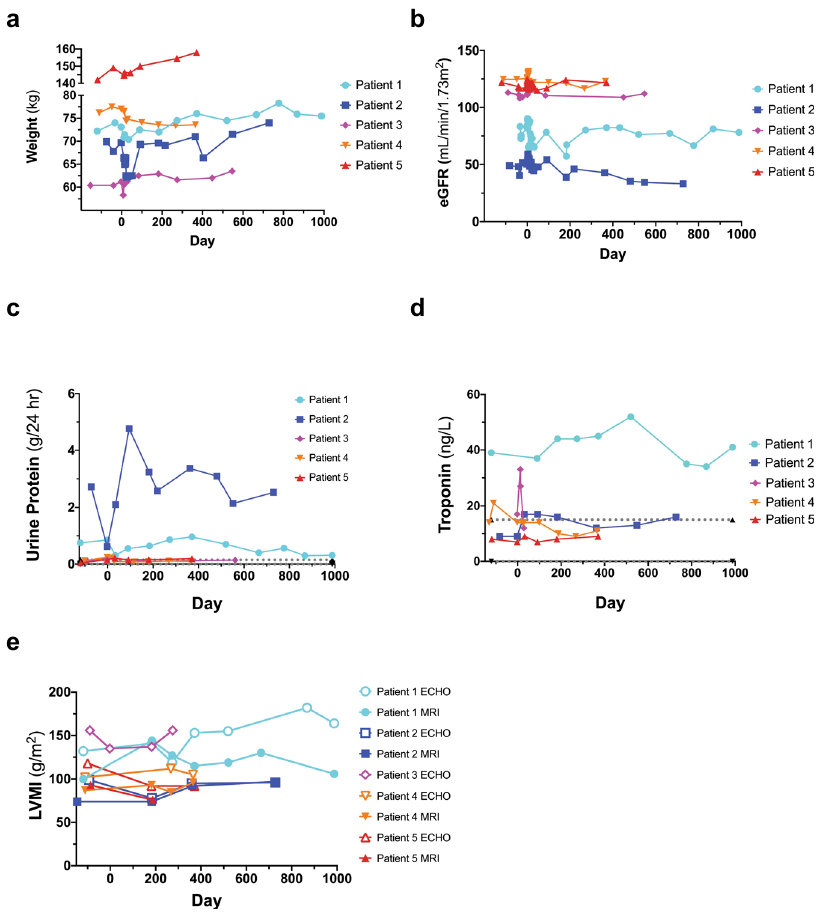
Fig. 4 Clinical parameters. Weight ( a ), estimated Glomerular Filtration Rate (eGFR) ( b ), urinary protein secretion ( c ), troponin ( d ), and Left Ventricular Mass Index (LVMI) ( e ) was monitored during the course of the trial for all patients. eGFR was calculated using the Chronic Kidney Disease-Epidemiology Collaboration formula. Values from Magnetic Resonance Imaging (MRI) and Echocardiography (ECHO) are shown for LVMI ( e ). Patient 3 did not attend all cardiac assessments and has been omitted from Fig.